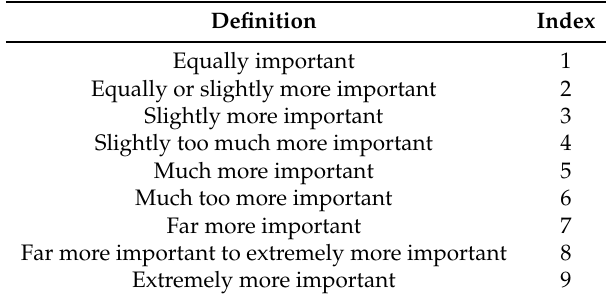
Table 2. The scale and its description of Saaty’s pairwise comparison